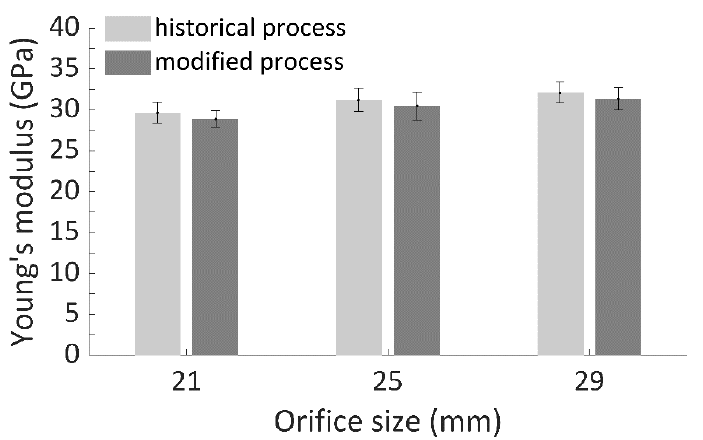
Figure 5. Mean values of Young’s modulus obtained from the three-point bending test for the three different orifice